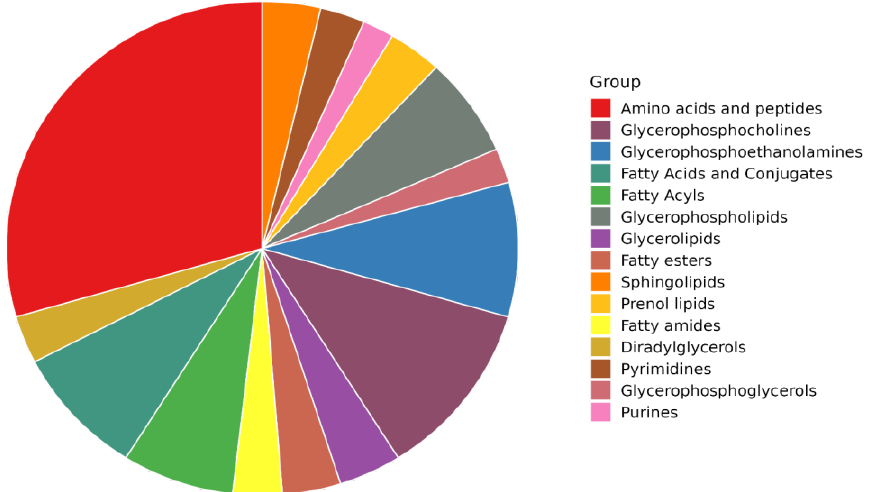
Figure 1. Pie chart diagram showing the distribution of the most abundant classes of compounds in Coppa Piacentina PDO samples, as revealed by untargeted metabolomics.